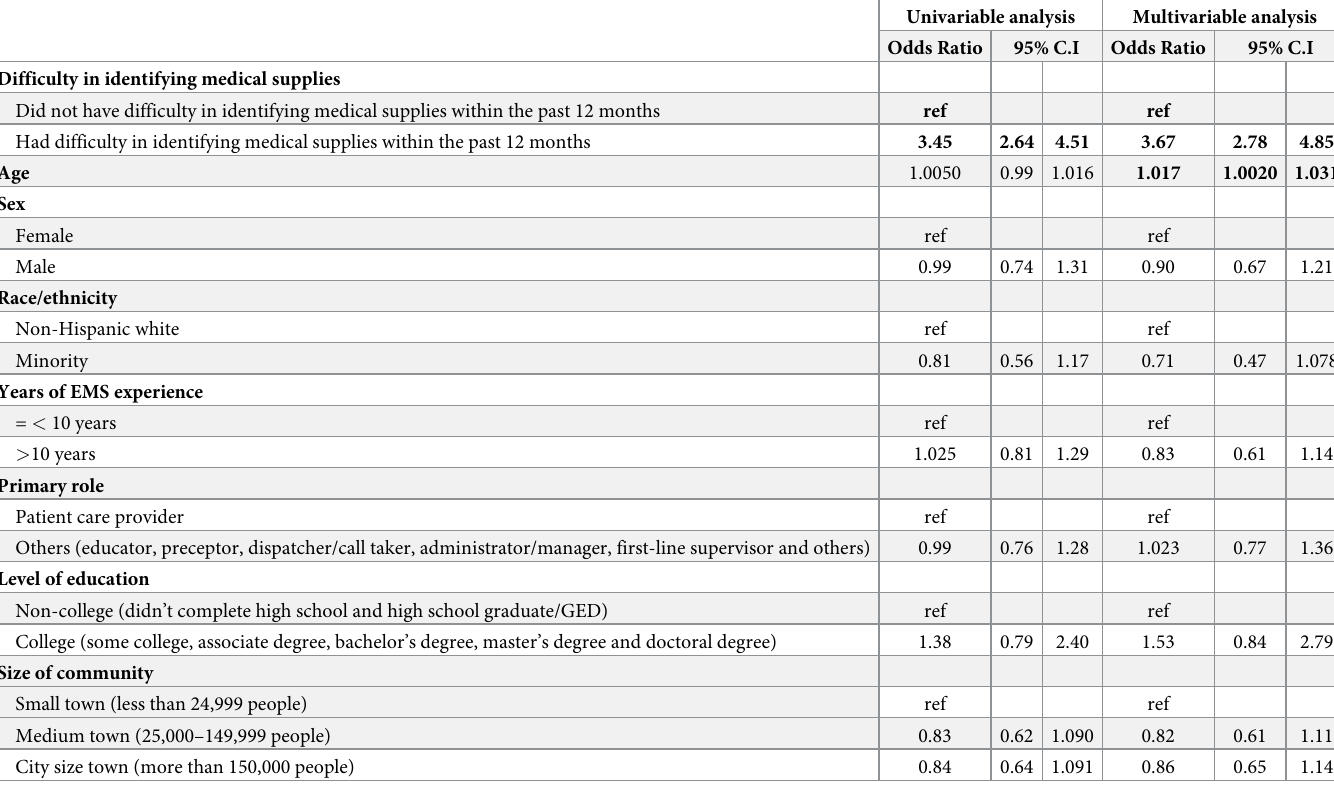
Table 6. Univariable and multivariable regression analysis for difficulty opening medical